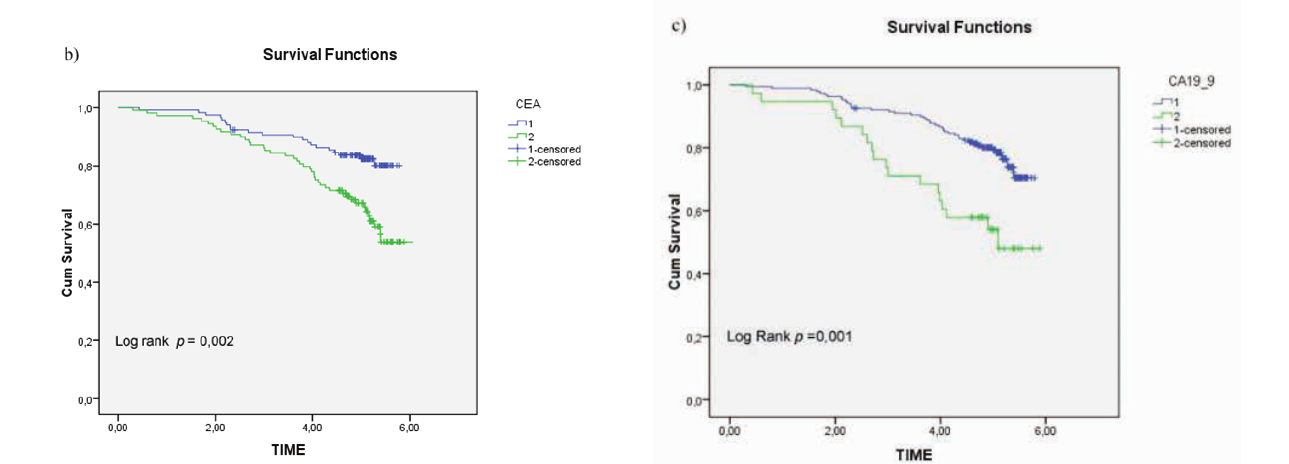
Figure 1: Box-plot diagram showing lymph node ratio (LNR) values in colorectal cancer Stages IIIA, IIIB and IIIC.